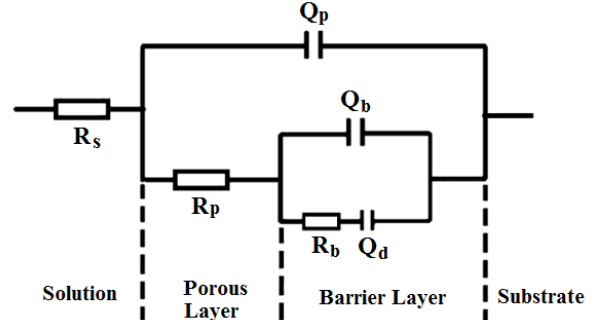
Figure 10. The diagram of equivalent circuit model R s ( Q p ( R p ( Q b ( R b Q d )))) [17]. The passive film on bare TA2 specimen is similar to the inner barrier layer of MAO coating on TA2. The equivalent circuit model R s ( Q b ( R b Q d )), which is obtained by discard- ing the elements for porous layer of the equivalent circuit model R s ( Q p ( R b ( Q b ( R b Q d )))), was